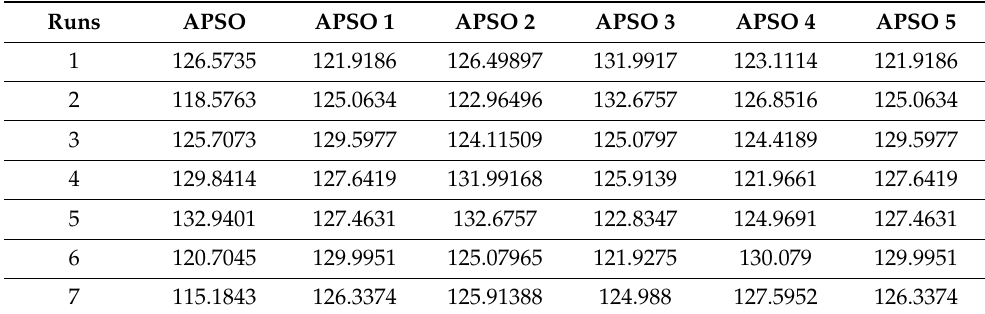
Table 13. APSO and its variants’ results for 500 PHEVs (30 Trials).